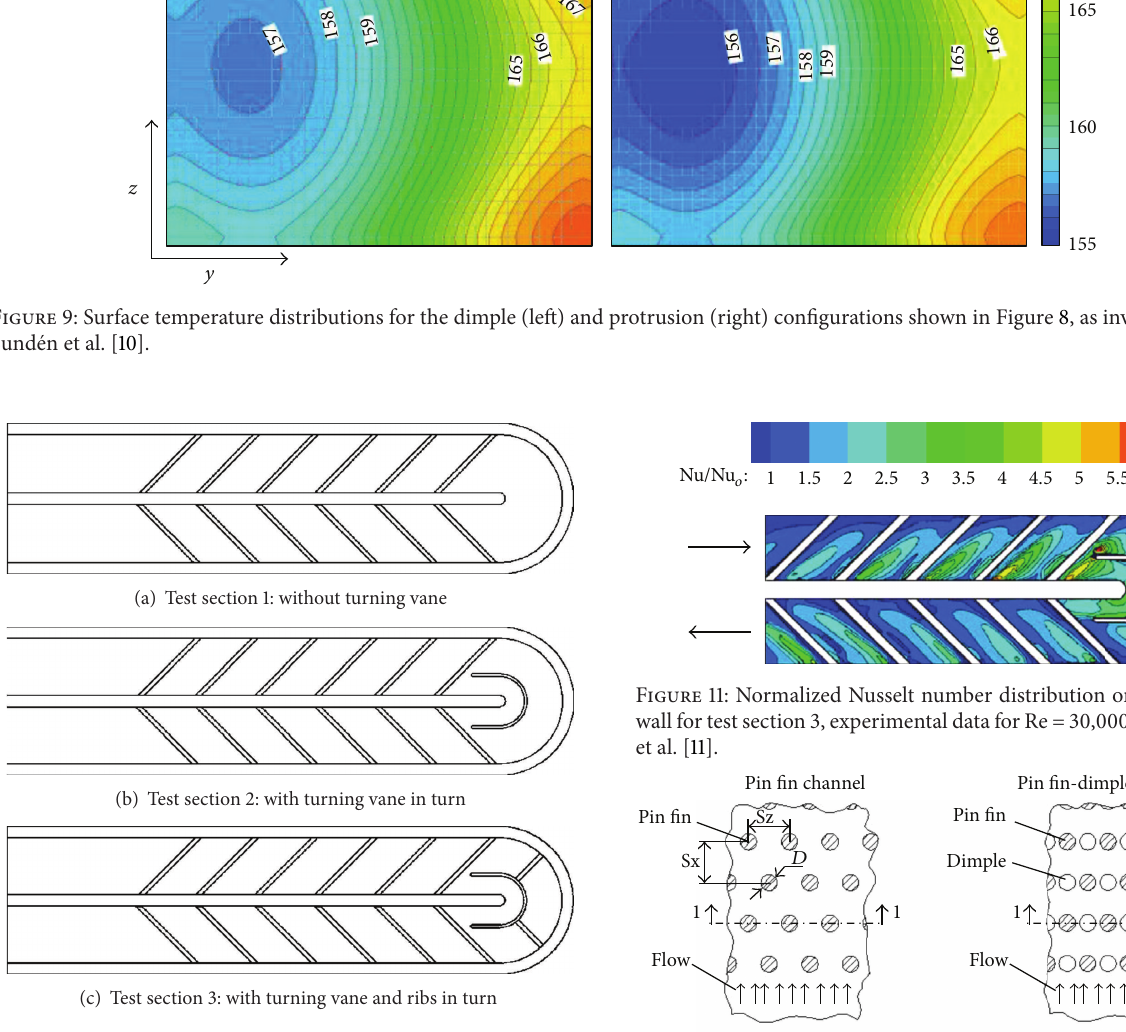
Figure 10: Vane turning test section arrangements, investigated by Chen et al. [11].